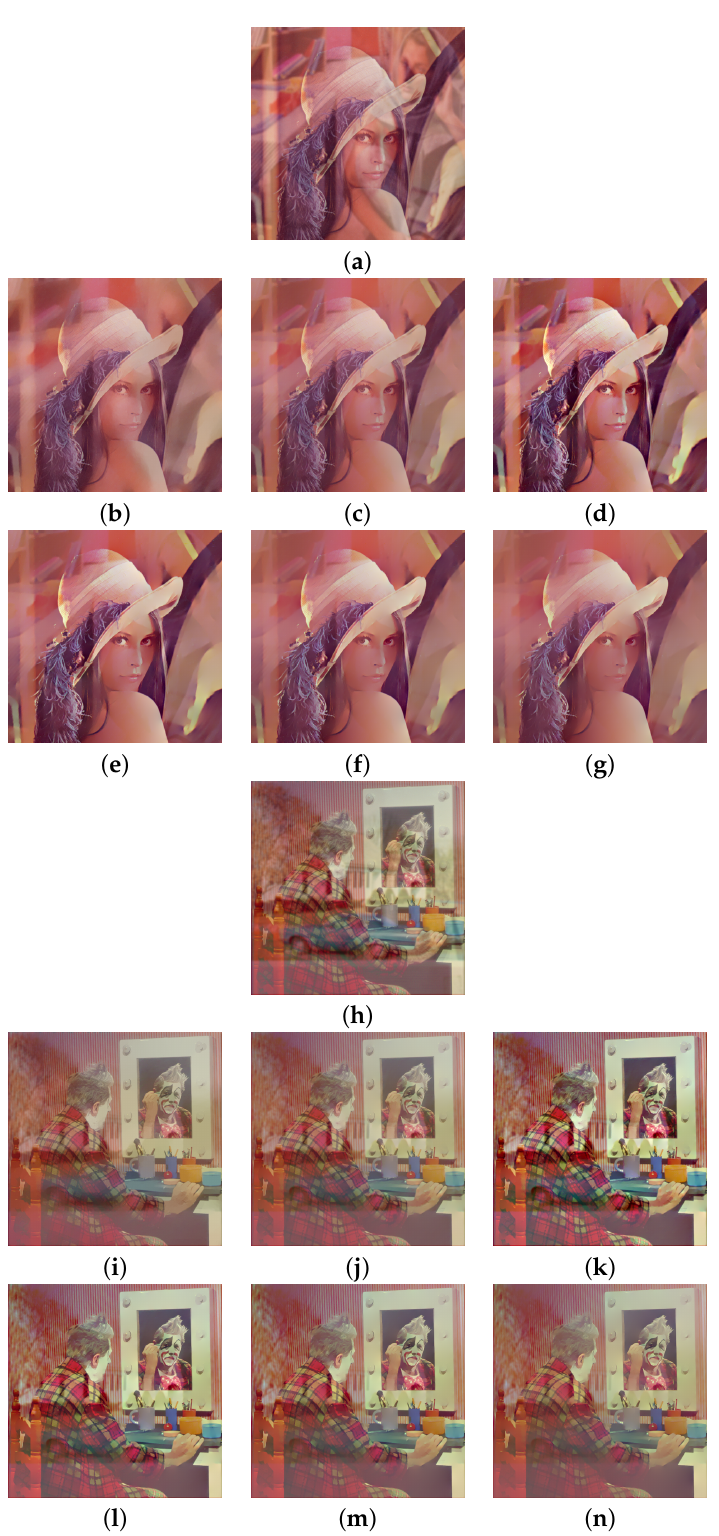
Figure 4. Reflection suppression results for synthetic glass images with w = 0.6. ( a , h ) Input images. ( b , i ) The results of algorithm [2]. ( c , j ) The results of algorithm [3]. ( d , k ), ( e , l ), ( f , m ), and ( g , n ) are the results of the proposed algorithm with N = 1,2,3,4,